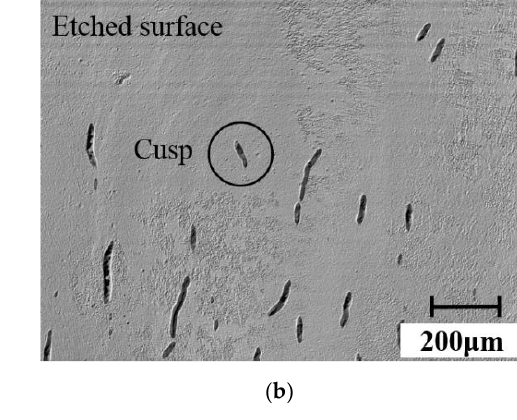
Figure 4. Schematic illustration of chemical etching technique. ( a ) Corrosion model, ( b ) Crack dis- tribution characteristics after corrosion at a subsurface depth of 96.7 μm under the action of the distribution characteristics after corrosion at a subsurface depth of 96.7 µ m under the action of the dressed wheel. dressed wheel.